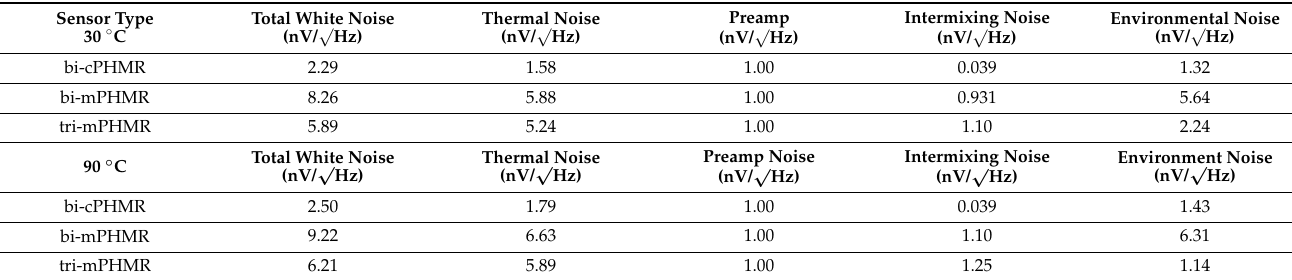
Table 1. White noise decompositions at 100 Hz at 30 °C and 90 °C. The sensing current was 1 mA. Sensor Type